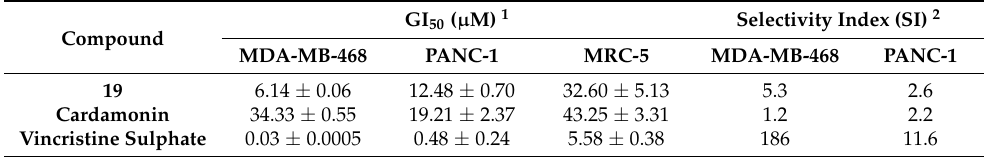
Table 1. GI 50 values of 19 against MDA-MB-468, PANC-1, and MRC-5 cells.